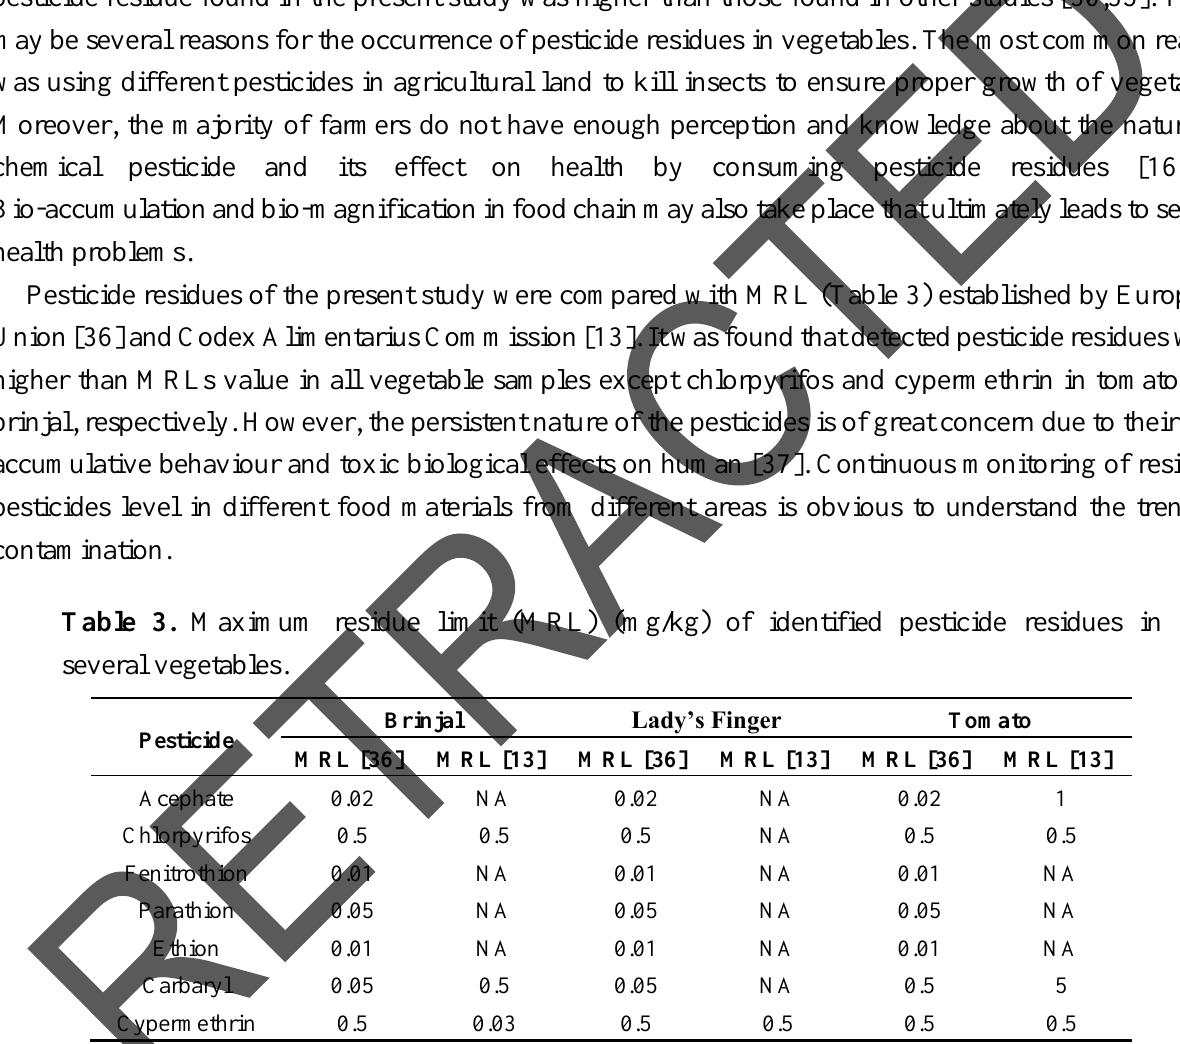
Table 3. Maximum residue limit (MRL) (mg/kg) of identified pesticide residues in several